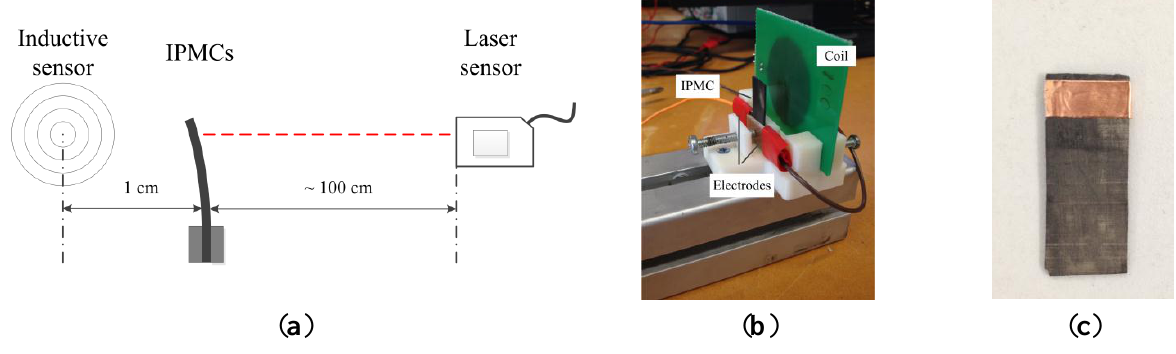
Figure 5. ( a ) Schematic, ( b ) a picture of the set-up, and ( c ) IPMC with conductive tape.